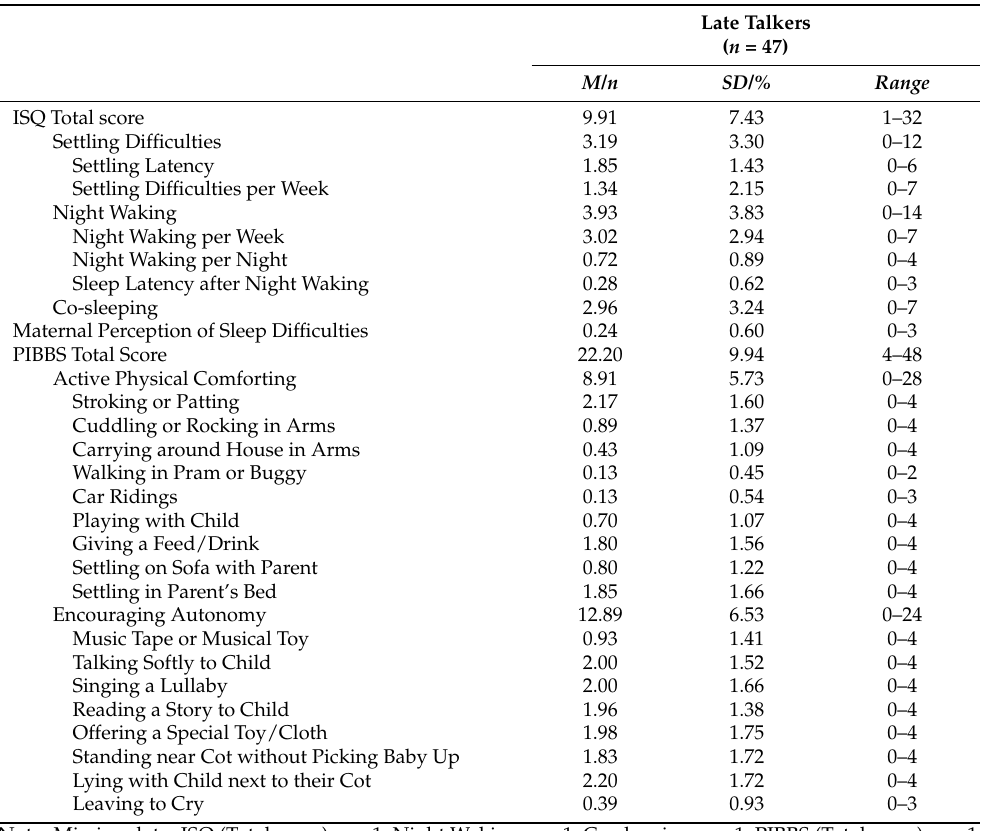
Table 2. Late Talkers’ Perceived Night Sleep Characteristics Assessed with the Infant Sleep Question- naire (ISQ) and Parental Bedtime Practices Assessed with the Parental Interactive Bedtime Behaviour Scale